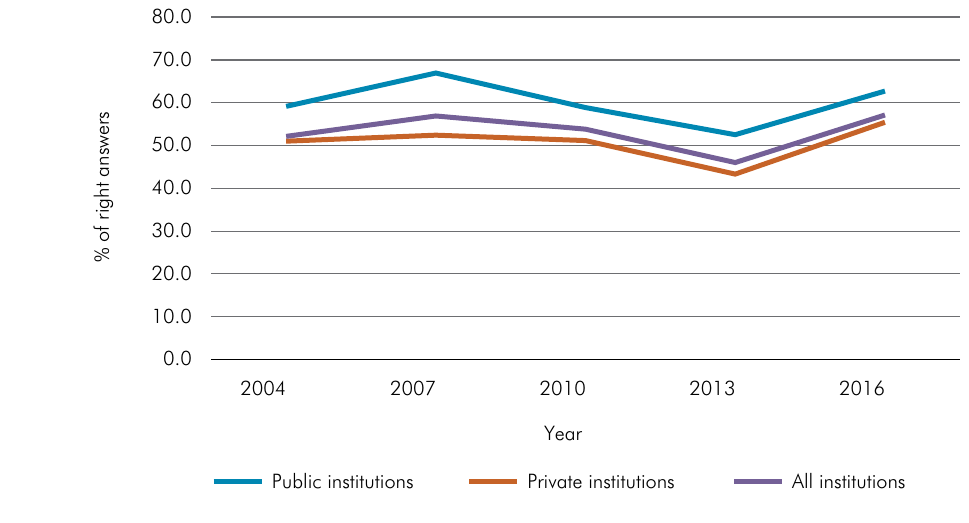
Figure 6. Mean percentage of right answers to the Enade specific assessment of Dentistry in public and private IES, ENADE 2004 to 2016, obtained from INEP. 12